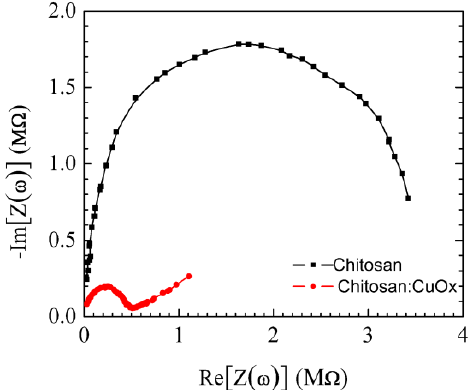
Figure 3. Opposite of the imaginary part of the impedance, plotted against the real part of the impedance, of chitosan and of chitosan:CuOx.